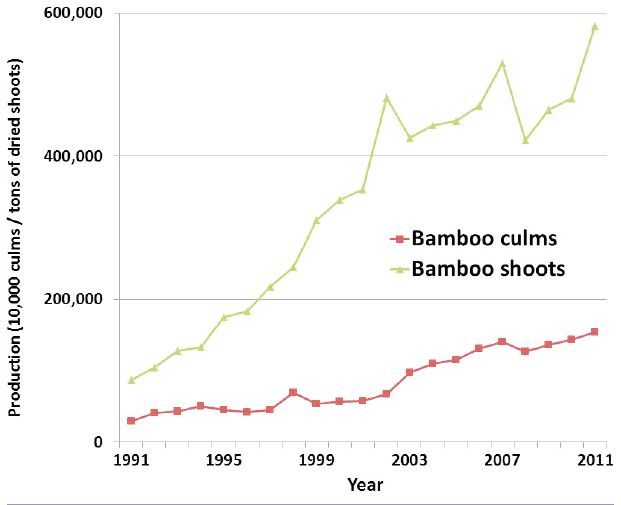
Fig. 3 . Evolution of bamboo culm and shoot production in China (National Bureau of Statistics of China, several